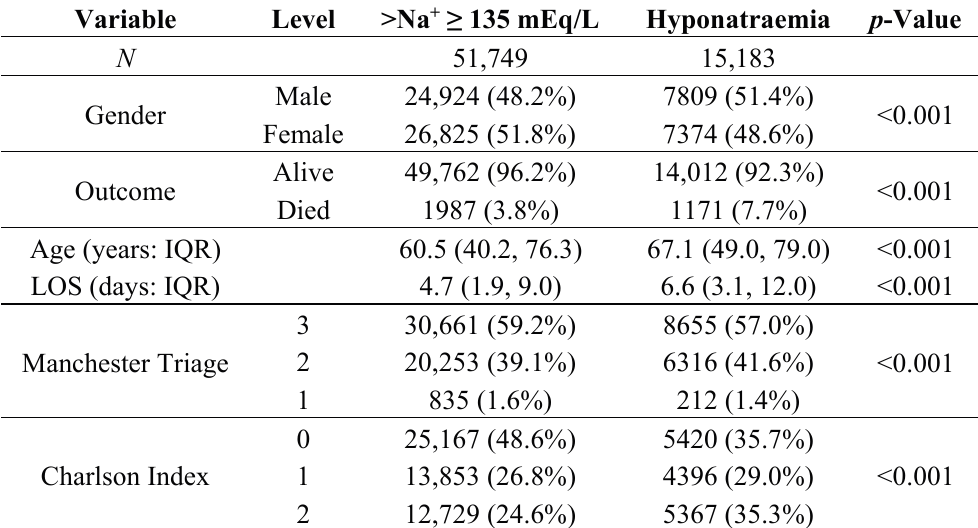
Table 1. Characteristics of Emergency Medical Admissions by admission Na + status.